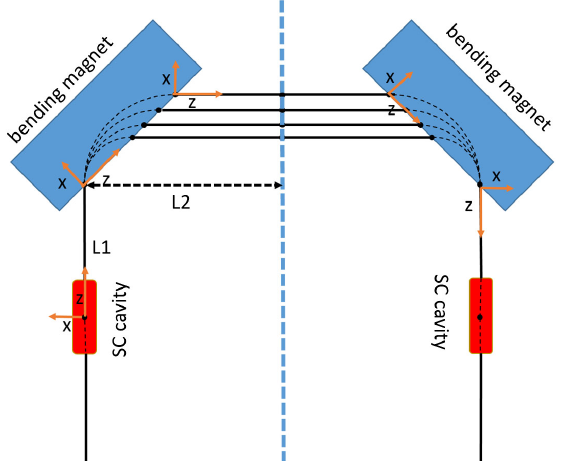
FIG. 1. A schematic plot of the two fixed field bending magnet phase shifter. Here, y is the vertical direction pointing out of the plane.